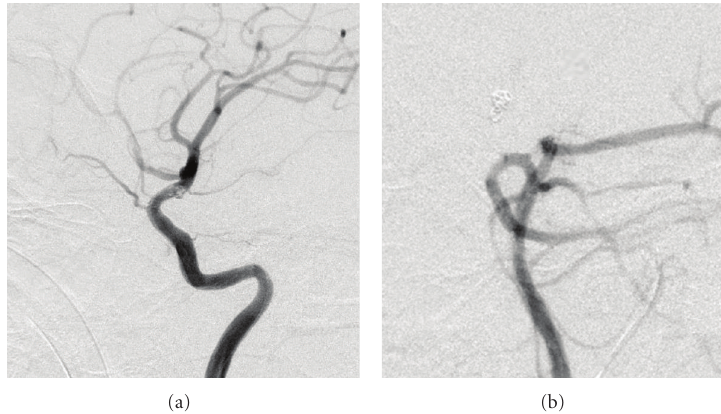
Figure 3: Follow-up DSA. (a, b) The follow-up DSA did not show the recurrence of ID of the